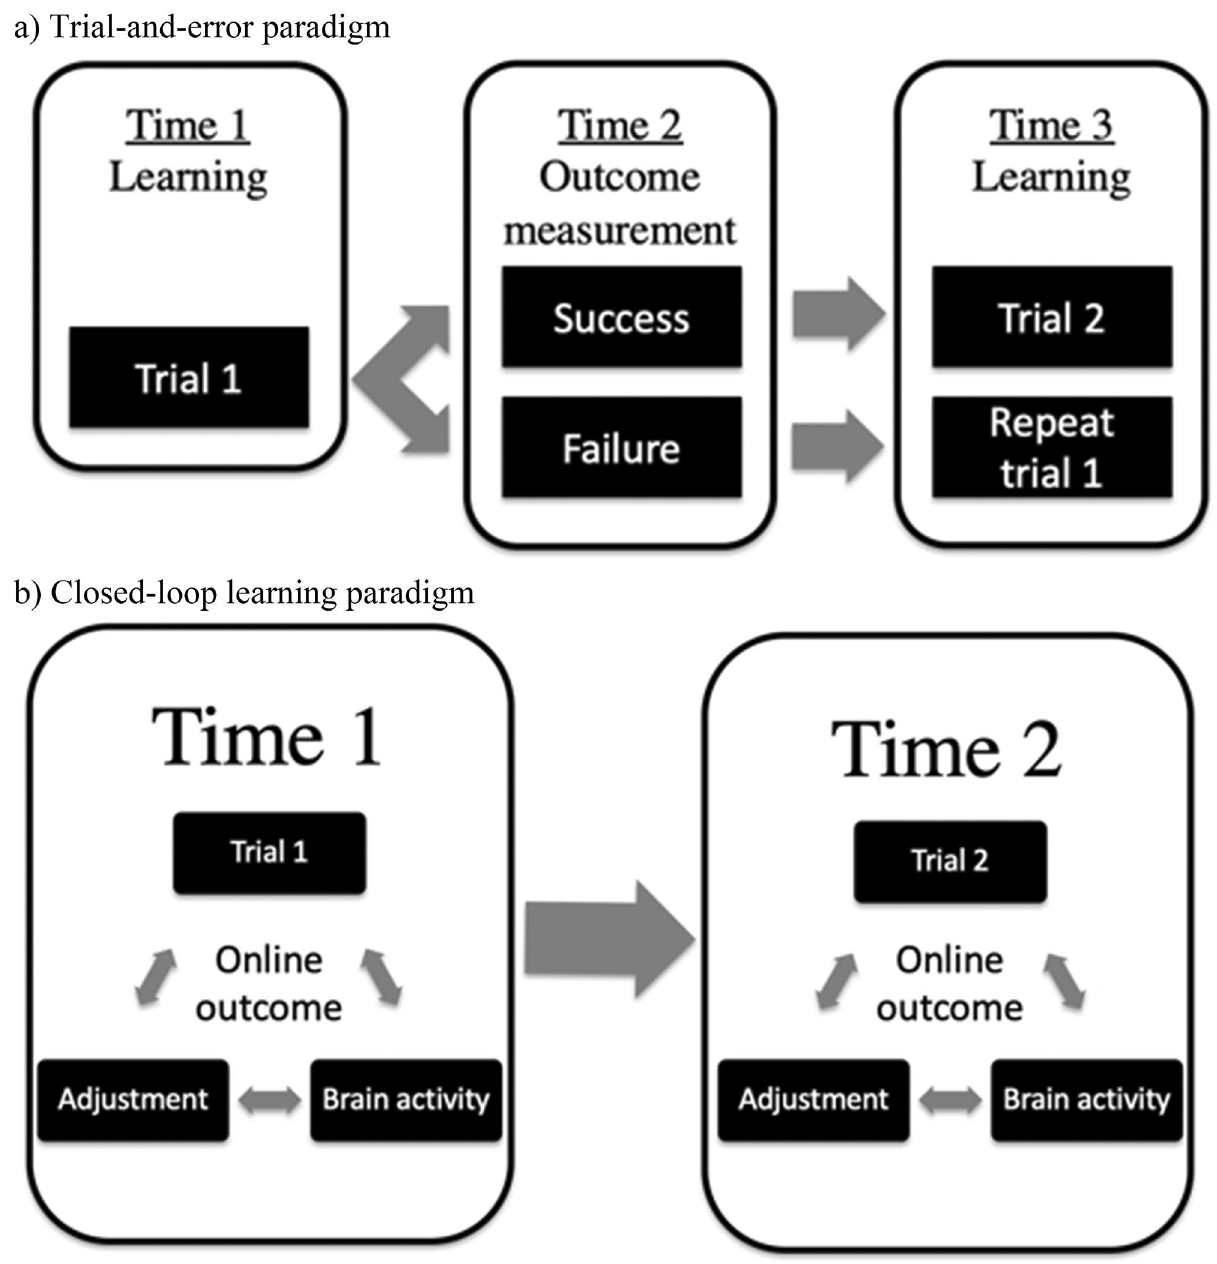
Figure 1. Illustrations of traditional versus looped learning paradigms. ( a ) In a traditional trial-and-error learning paradigm, the entirety of time 1 is spent learning. A separate instance, time 2, is dedicated to measuring the outcome of learning, and can either result in success or failure. The next step, time 3, is either dedicated to learning trial 2 (if the result of outcome measurement was success) or repeating trial 1 (ideally with an adjustment, and in the case of failure at time 2). ( b ) In a closed-loop learning paradigm, time 1 is spent learning, but includes online error-detection based on brain activity and real-time adjustment, which modifies the manner in which learning occurs to ensure successful learning before moving onto trial 2. Arrows are bidirectional since learning and adjustment has an effect on the brain, which in turn drives the learning process and necessary